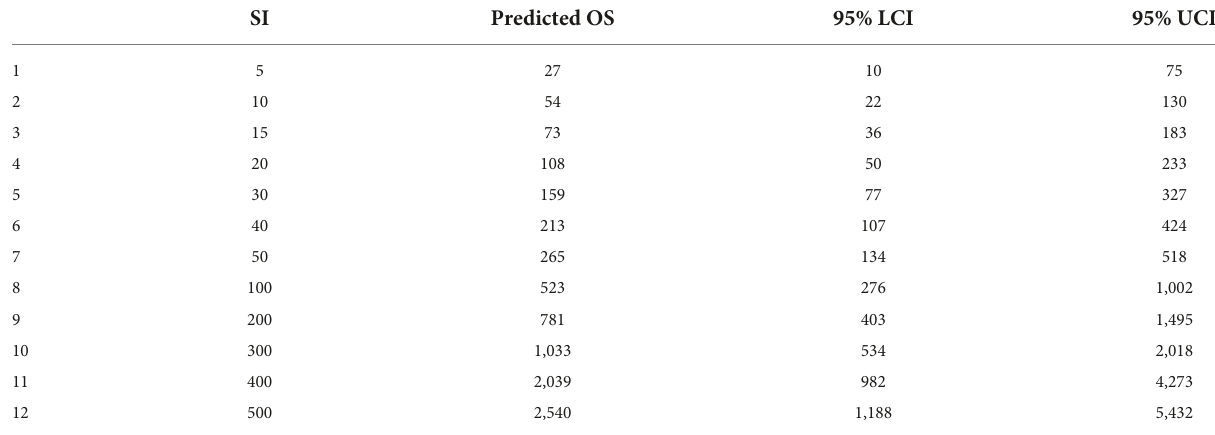
TABLE 2 Predicted dung beetle oversampling values (Predicted OS) on their original scale (i.e., natural log exponential) as a function of sampling intensity (SI, number of traps). SI Predicted